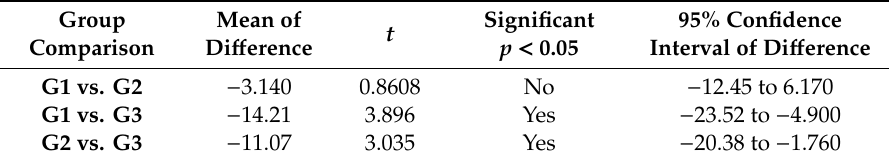
Table 4. Bonferroni’s multiple comparison test to compare the bone fraction occupancy inside the threads (BAFO%) values between the groups.